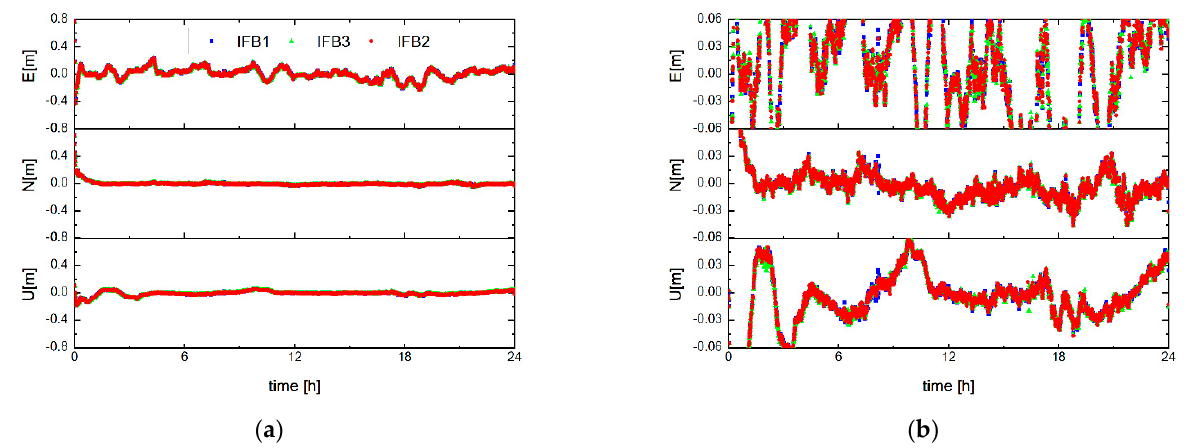
Figure 6. The 3D positioning errors of UC-PPP for station KRGG on DOY 001, 2022. The E, N, and U represent the errors in positioning in the east, west, and south up directions of station KRGG, respectively. Subfigures ( a , b ) represent global positioning error and local positioning error.